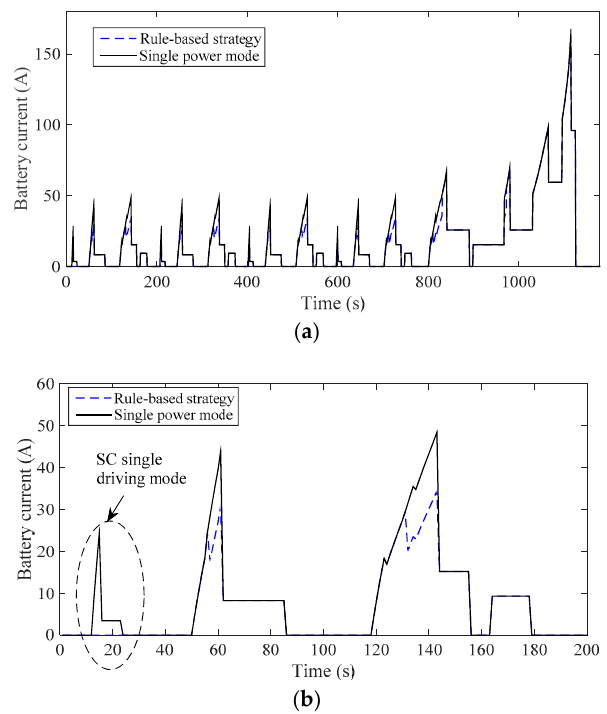
Figure 15. Battery current along NEDC. ( a ) Battery current along NEDC; ( b ) Battery current along an urban driving cycle.